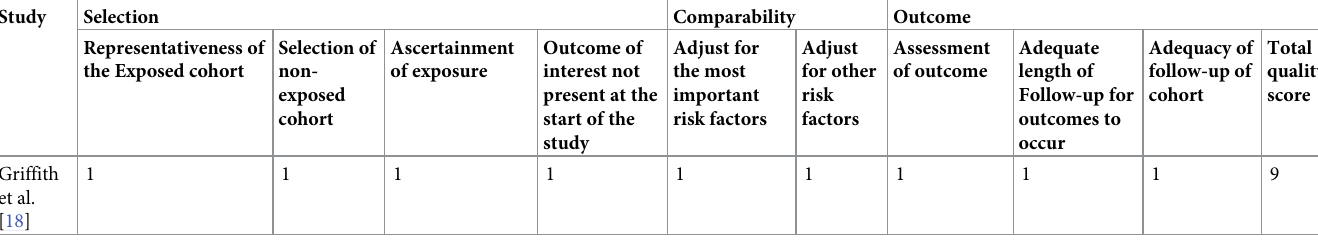
Table 3. Quality assessment of the observational studies by The NOS